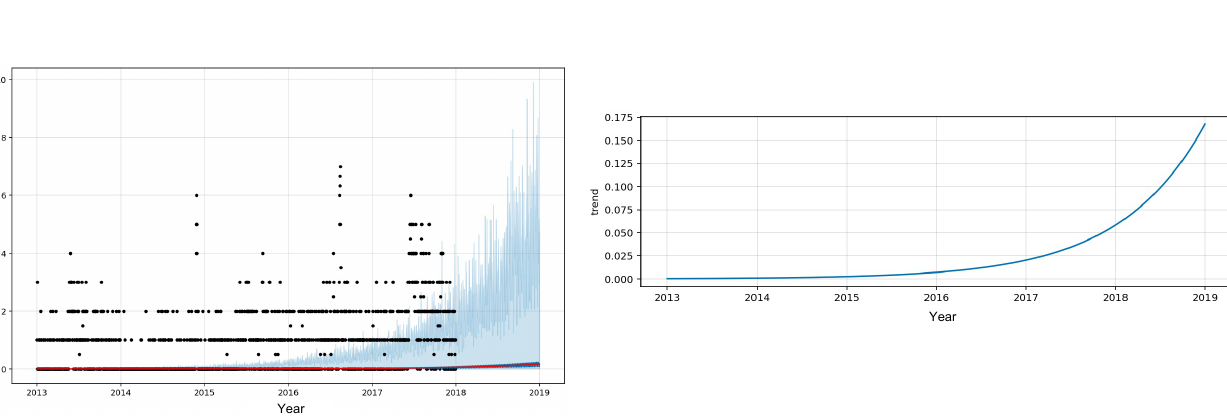
Figure A5. Left : One year forecast (2018 test data) from Prophet-BU Model for Essex county in MA. N.B: The solid blue line shows the average forecast while the solid red line shows the observed trend of NWOCI and the light blue region represents the 80% confidence interval for the forecast uncertainty. Also, the scatter points represent the historical values in the training data (2013–2017). Right : Trend decomposition from Prophet-BU Model for Essex county in